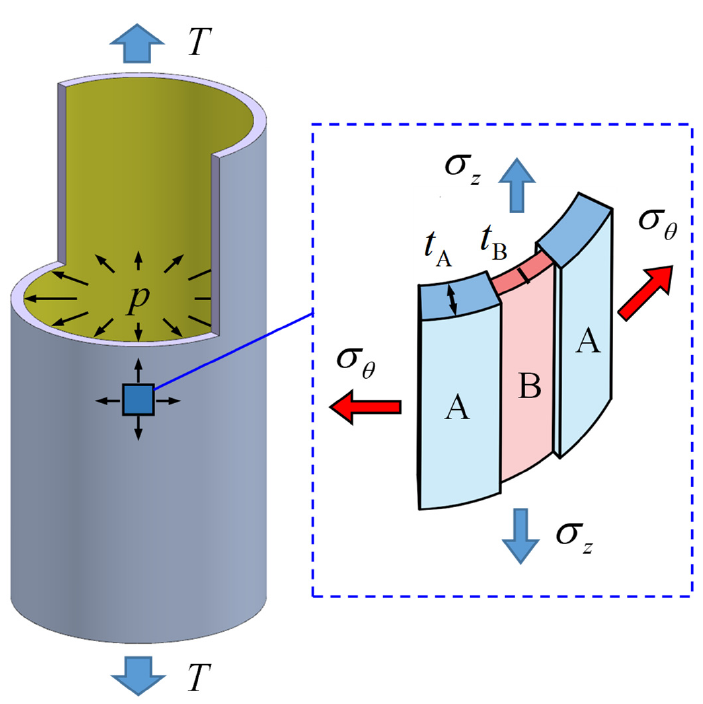
Figure 1. Schematic diagram of the axial groove in tubes.